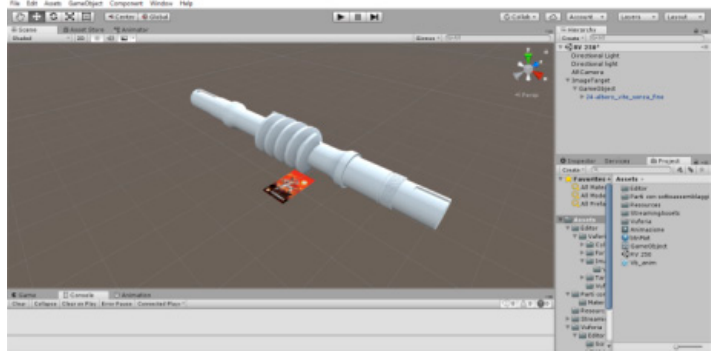
Figure 27. View of tree with Unity (scale 1:1).